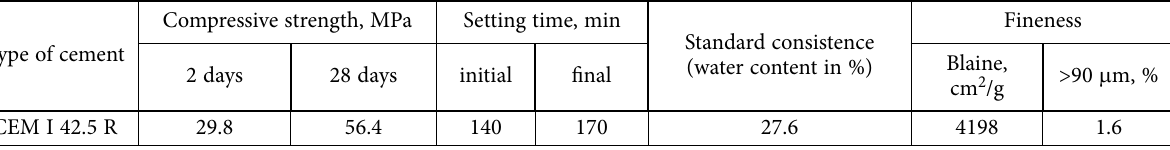
Table 1. Physical properties of the cement according to LST EN 197-1:2011 (Lietuvos standartizacijos departamentas, 2011) Compressive strength, MPa Setting time, min Type of cement